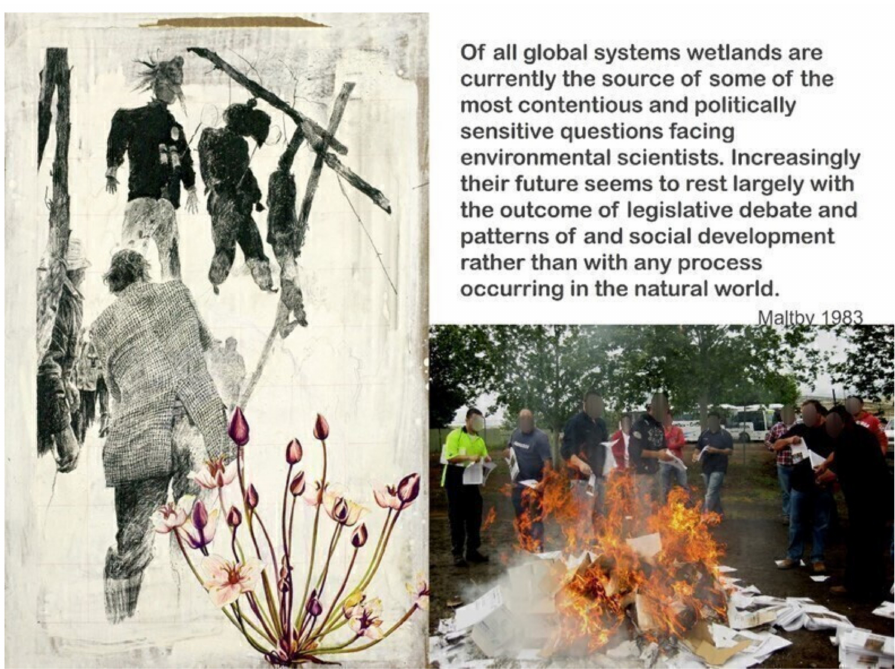
Figure 1. Hanging of the effigies of conservationists on the Somerset Levels, UK by farmers opposed to plans to rewet drained wetlands in 1983; Source: Jeremy Purseglove 2017 [1]. Farmers in the Murray–Darling river basin, Australia, concerned about loss of water for irrigation, burning copies of the 2010 water plan. Source: AAP/Gabrielle